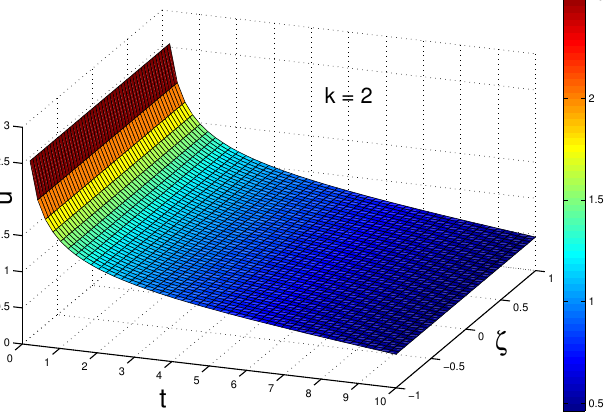
Figure 4. The graph of u ( x , t ) given by Equations (23) and (24) for k =